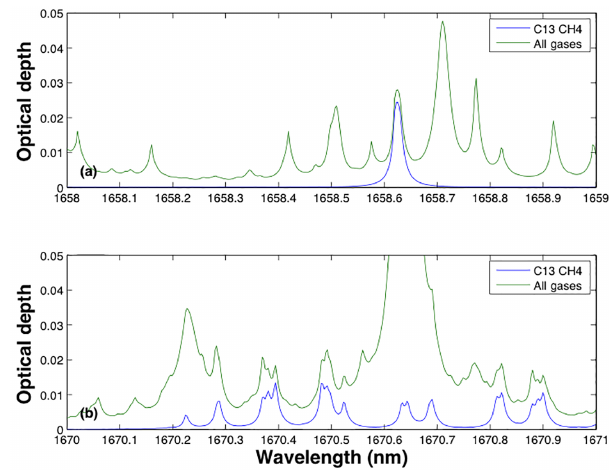
Figure 5. Optical depth covering two narrow 13 CH 4 spectral re- gions in band 2 of TANSO-FTS-2: the green line represents optical depth of all gases present in this portion of the spectrum (CH 4 , CO 2 and H 2 O), whilst the blue line shows optical depth of purely the methane isotopologue 13 CH 4 : panel (a) indicates optical depth in the wavelength range 1658–1659nm; panel (b) shows optical depth in the wavelength range 1670–1671nm. Table 4. Summary of DOFS characteristics for all scenarios’ six surface albedos. Max DOFS for surface